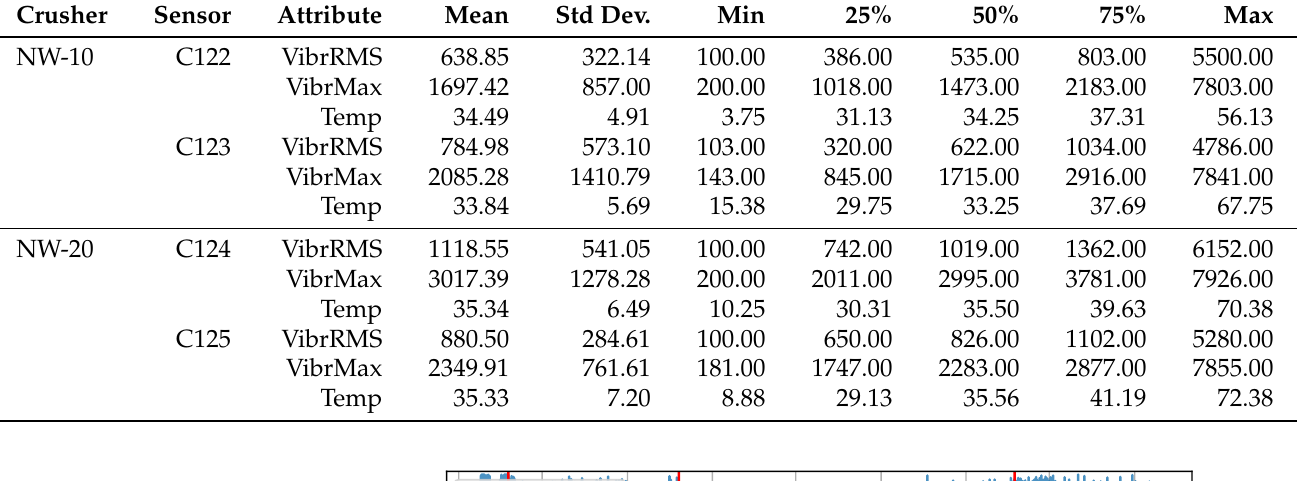
Table A2. Descriptive statistics of each attribute in the coal crusher data, the statistics include: